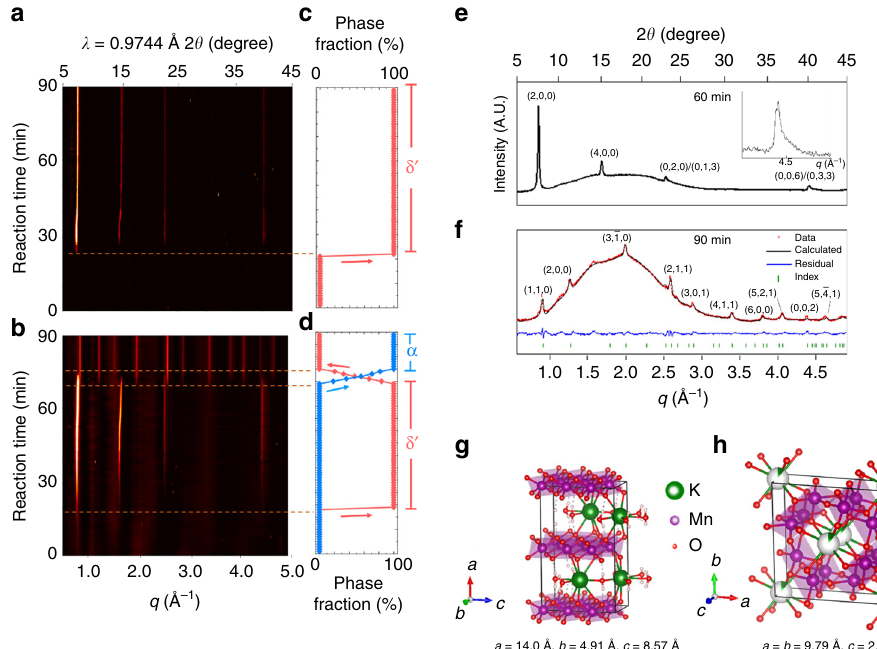
Fig. 4 In situ X-ray scattering analysis of P K = 0.33 and P K = 0.2 . a , b The evolution of X-ray scattering pro fi le with time during hydrothermal synthesis along P K = 0.33 ( a ) and P K = 0.2 ( b ). c , d Phase fraction evolution calculated from the intensities of diffraction peaks in a , b , respectively. e , f X-ray scattering pro fi les of the δ ′ phase ( e ) and α phase ( f ). The inset fi gure in d shows the asymmetrical tail of the peak at q = 4.45 Å − 1 . The broad peak around q = 1.5 – 2.5 Å − 1 is caused by imperfect background removal, and is discussed in Supplementary Note 3. g , h Re fi ned structures of the δ ′ phase ( g ) and α phase ( h ). Manganese (purple), potassium (green), and oxygen (red) are represented by spheres, and the unit cell is identi fi ed by gray lines (see